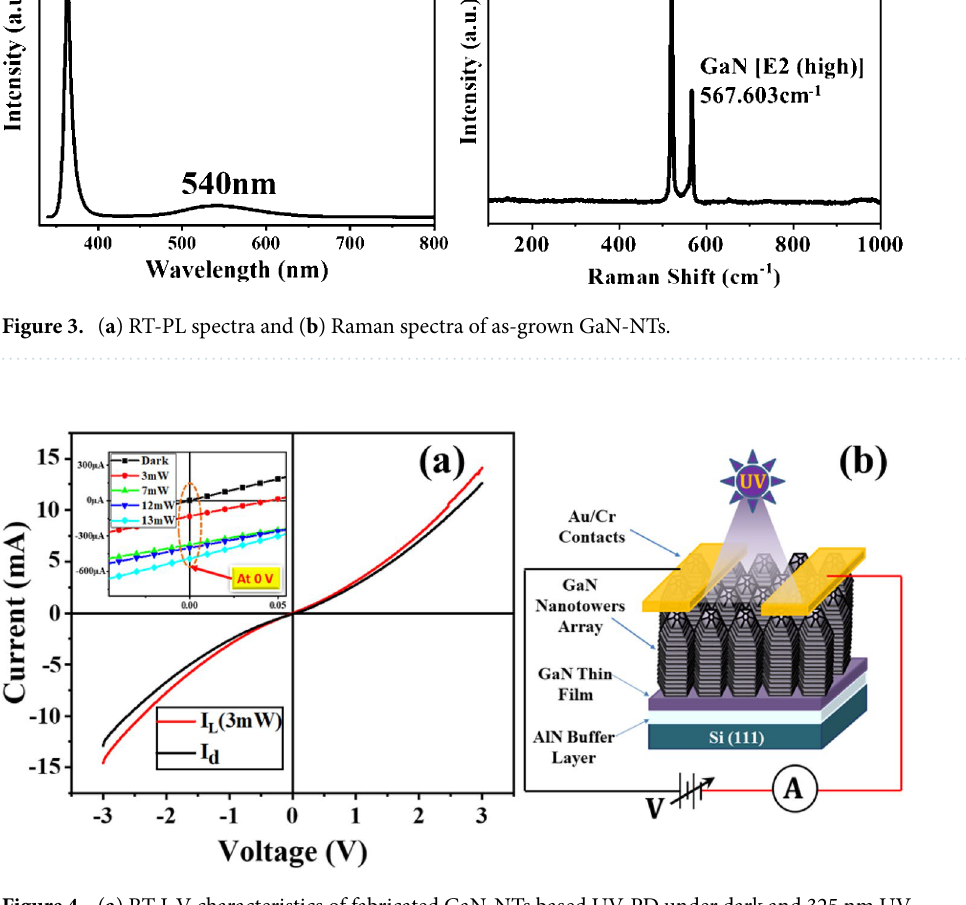
Figure 4. ( a ) RT I-V characteristics of fabricated GaN-NTs based UV-PD under dark and 325 nm UV illumination with 3 mW optical power. Inset: indicate self-powered characteristic at various optical power, ( b ) Schematic image of the fabricated GaN-NT array based